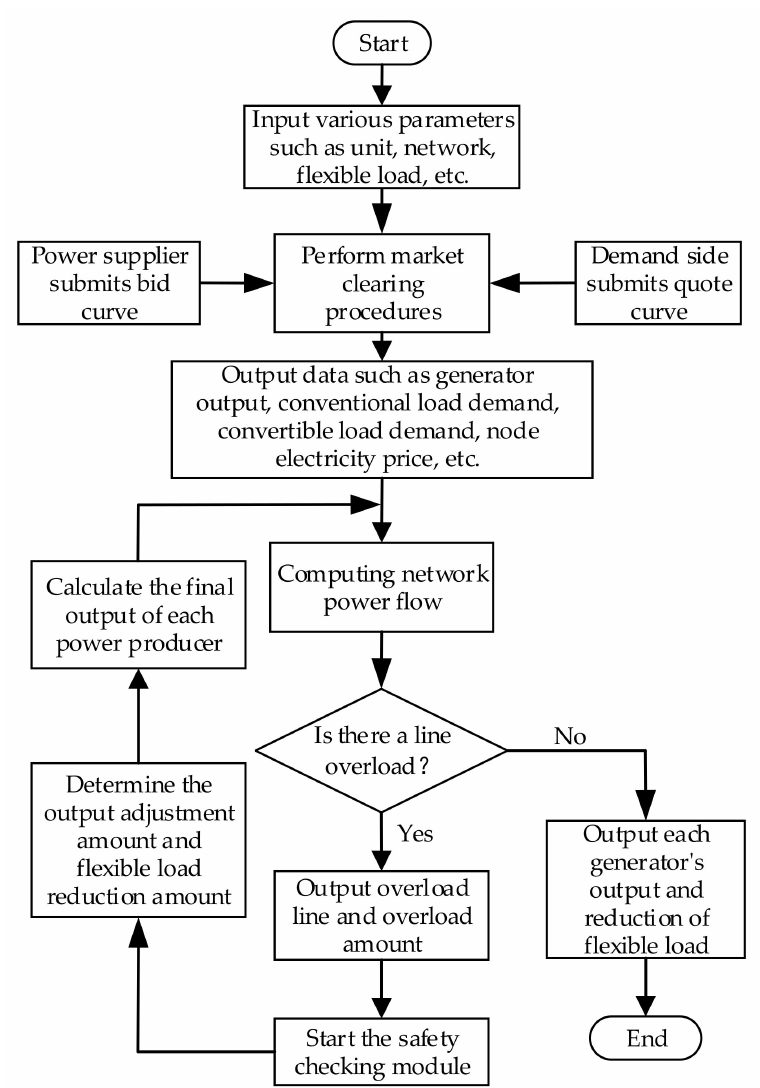
Figure 6. Market clearing and safety checking process that considers the flexible